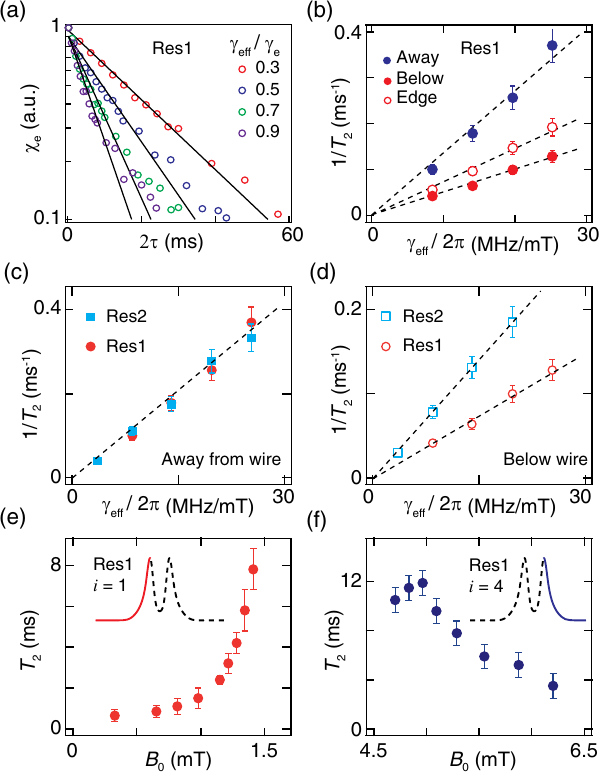
FIG. 4. Spatial magnetic noise. (a) Echo integral χ as a e function of the delay 2 τ between the π = 2 pulse and the echo, measured with Res1 for transitions i ¼ 1 – 4 , at fields B 0 corre- sponding to the same f Δ ¼ − 2 . 5 MHz (i.e., h x i ∼ 0 . 5 μ m). Open circles are the data, and solid lines are exponential fits yielding the decay rate T − 1 2 . (b) Extracted echo amplitude decay rate T − 1 2 with Res1 as a function of γ for transitions i ¼ 1 – 4 and f Δ ¼ eff − 2 . 5 MHz (spins below the wire, red dots), f − 4 MHz (spins Δ ¼ closer to the wire edge, red circles), and f Δ ¼ 0 MHz (spins far away from the wire, blue dots). The dashed lines are linear fits. (c, d) Comparison between resonators. Echo amplitude decay rate T − 1 2 as a function of γ measured with Res1 (transitions i ¼ 1 – 4 , eff red dots) and with Res2 (transitions i ¼ 6 – 10 , blue squares). Panel (c) shows the data for f Δ ¼ 0 (spins far away from the wire) and panel (d) for spins below the wire. (e) Coherence time T 2 measured with Res1 as a function of B 0 on the low-field peak of the i ¼ 1 transition. (f) Coherence time T 2 measured with Res1 as a function of B 0 on the high-field peak of the i ¼ 4